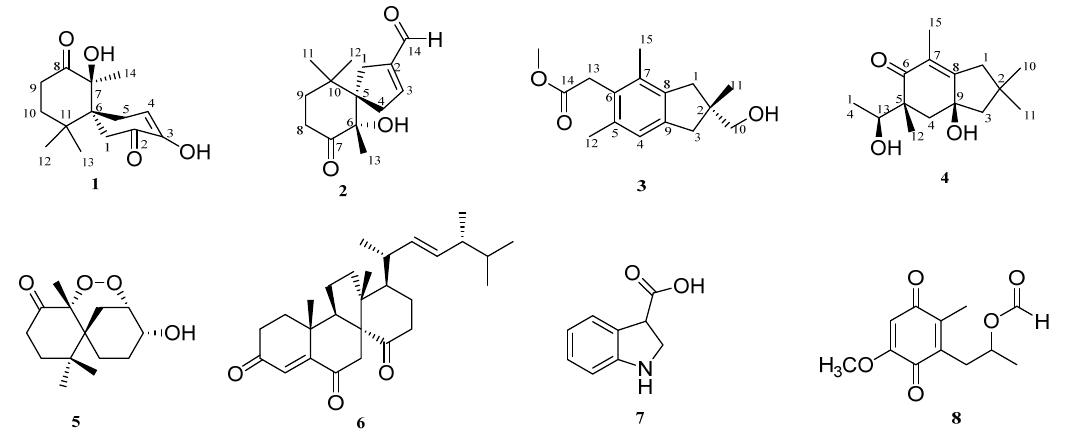
Figure 1. Chemical structure of compounds 1 – 8.